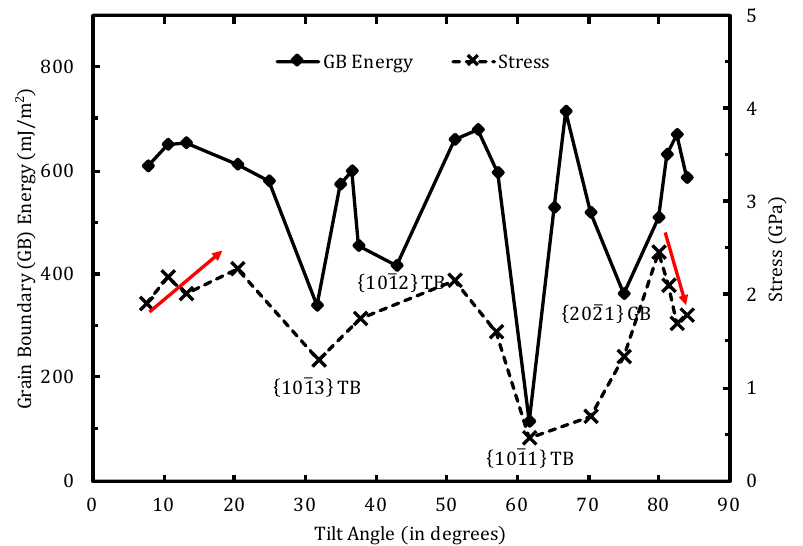
Figure 15. A plot showing the correlation between grain boundary energy and nucleation stress with tilt grain boundaries, data from